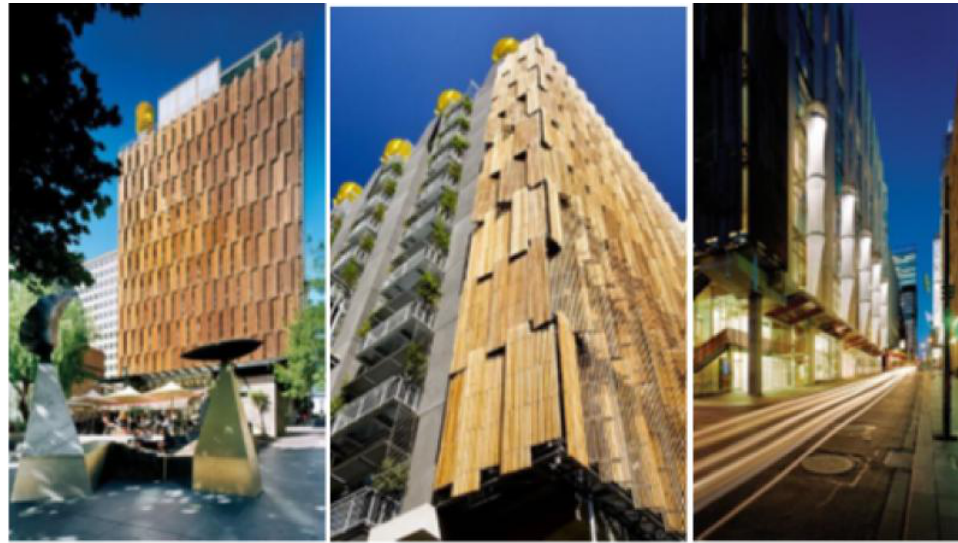
Fig. 1: CH building: right: spray of water to cool the southern facade, 2